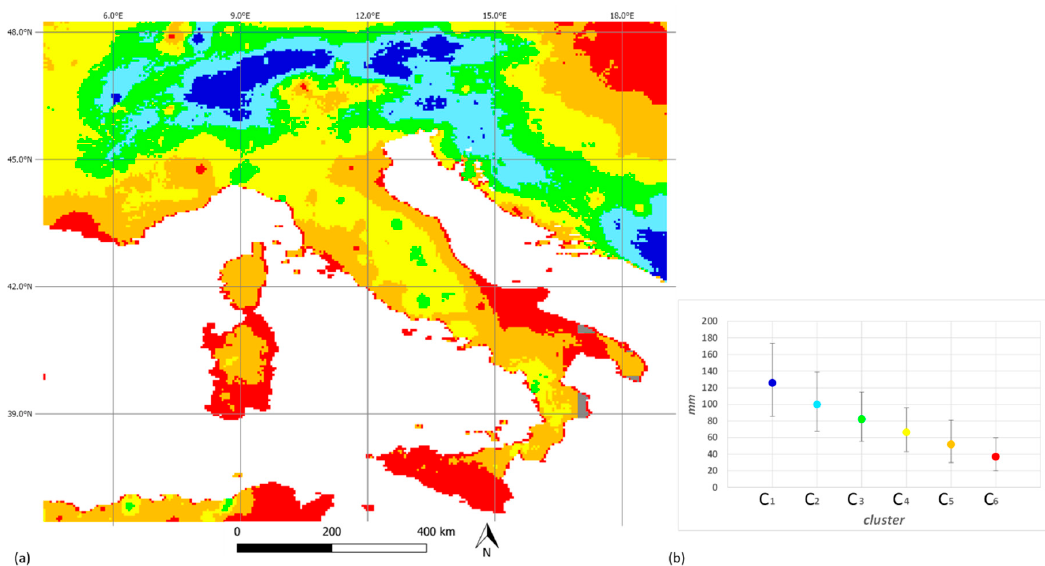
Figure 4. Distribution-based clustering: ( a ) cluster map; ( b ) descriptive triplets [Q1, Median, Q3] (centroids) estimated on the total observational period; coloured points indicate the median values whereas the error bars indicate Q1 and Q3 respectively. ( a ) has to be read according to the colour / cluster association rule in ( a ); grey pixels mask CHIRPS artefacts, which will be corrected in the next v2.1 version (Pete Peterson, private communication, 2019). Table 1. Clusters based on the values of triplets [Q1, Median, Q3] estimated over the period 1981–2018 (Figure 4) with the respective number of pixels. Cluster Number of Cluster